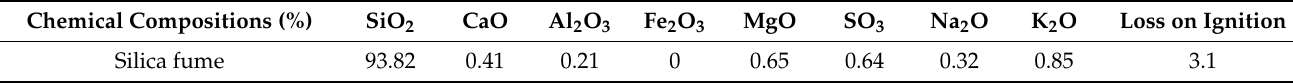
Table 4. Chemical compositions of silica